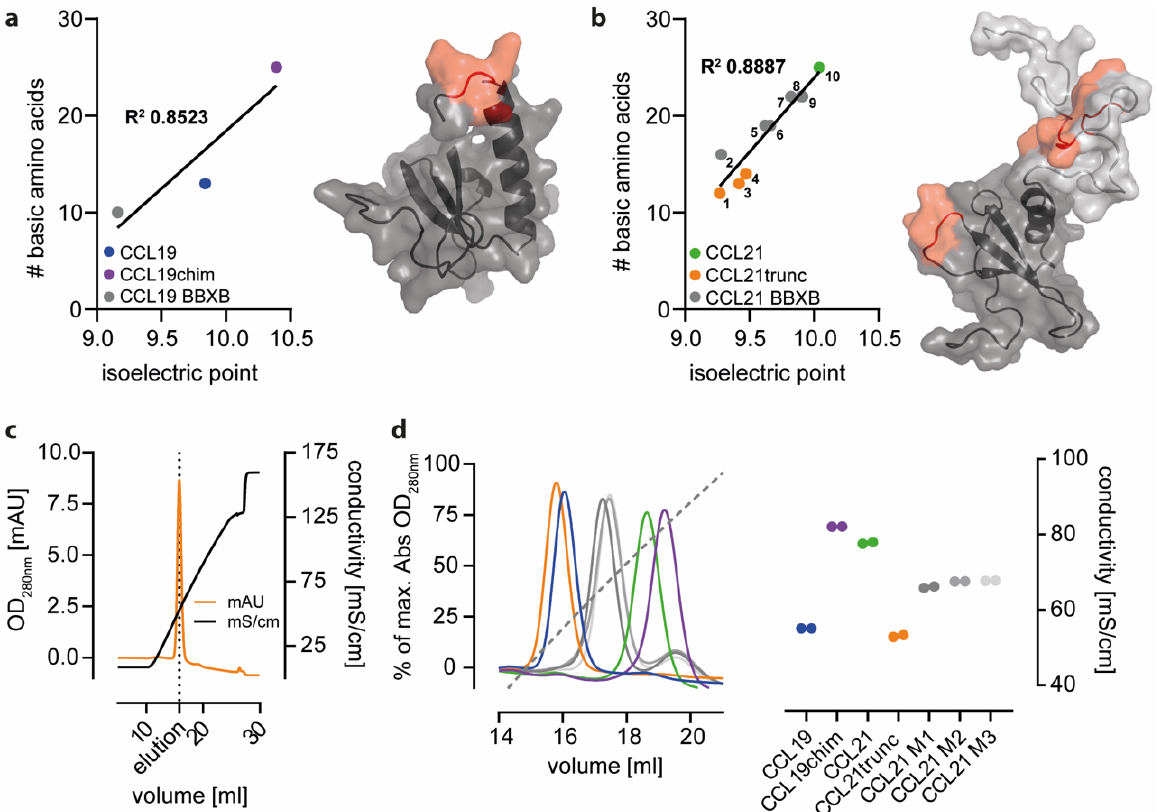
Figure 3. Basic amino acids on the chemokine surface determine heparin binding strength. ( a / b ) Correlation of the actual number of basic surface amino acids and the corresponding calculated chemokine isoelectric point of different CCL19 ( a ) and CCL21 ( b ) variants (1: CCL21trunc74, 2: CCL21 M1/2/3, 3: CCL21trunc79, 4: CCL21trunc81, 5: CCL21 M1/3, 6: CCL21 M1/2, 7: CCL21 M1, 8: CCL21 M3, 9: CCL21 M2, 10: CCL21). Positions of basic amino acids (red) within the chemokines are depicted in the corresponding protein surface representation (PDB: CCL19 2MP1; CCL21 2L4N). The polar C-terminus of CCL21 is shown in light gray. ( c ) Heparin binding strength was determined by loading a HiTrap heparin HP column with 50 μ g of the indicated chemokine, followed by elution with 2 M sodium chloride. Conductivity (black line) and absorbance at 280 nm (orange line) were used to compare the individual elution profiles. Profile of CCL19chim is shown as an example. ( d ) Elution profiles of different chemokine variants as indicated in ( c ) (left; color code as depiced in the right panel) and the quantitative analysis of two independent experiments (right) showing different chemokine binding capacities to immobilized heparin using the indicated color coding for different chemokine variants.